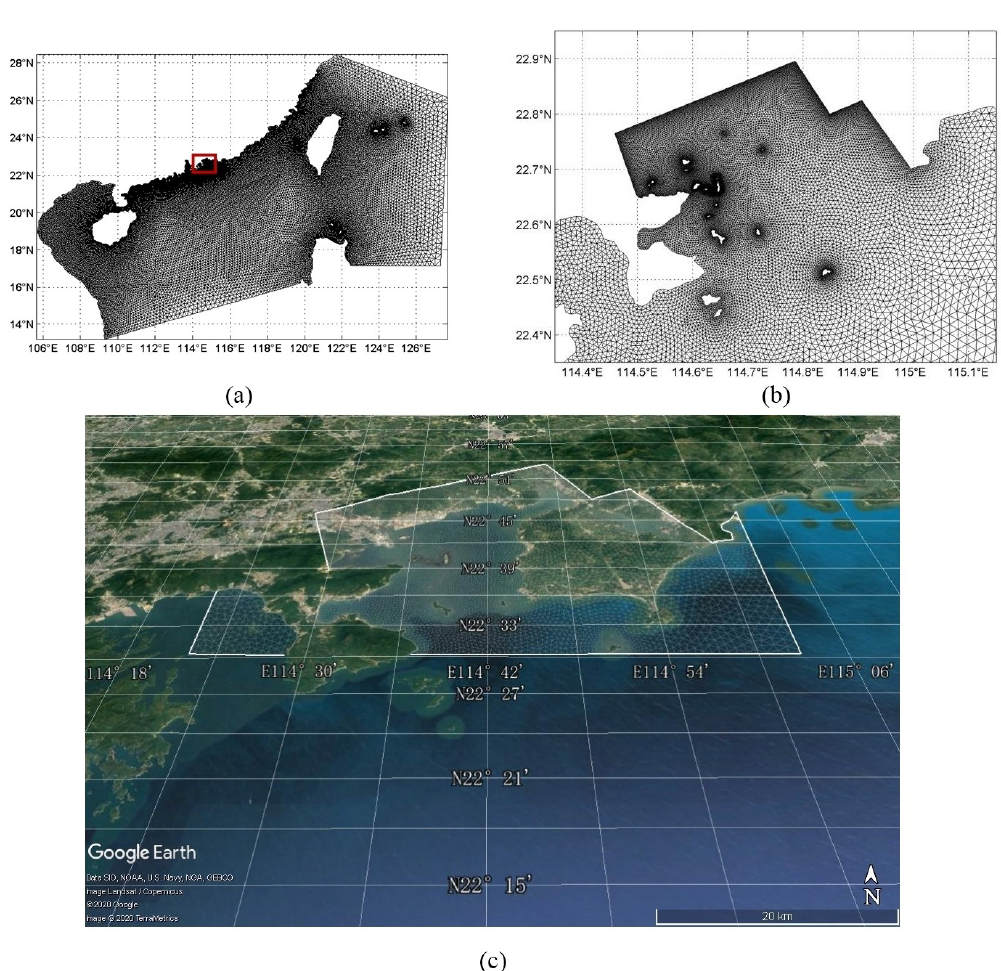
Figure 4. A computational domain (a) and the domain over the study area (b) . The satellite image (c) was obtained from © Google Earth (map data © 2020 Google, © 2020